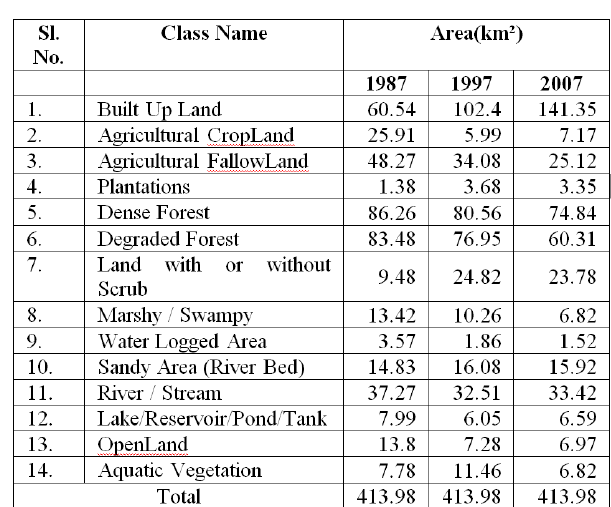
Figure 3. Classified Land Use Land Cover Map of 1987, 1997 and 2007